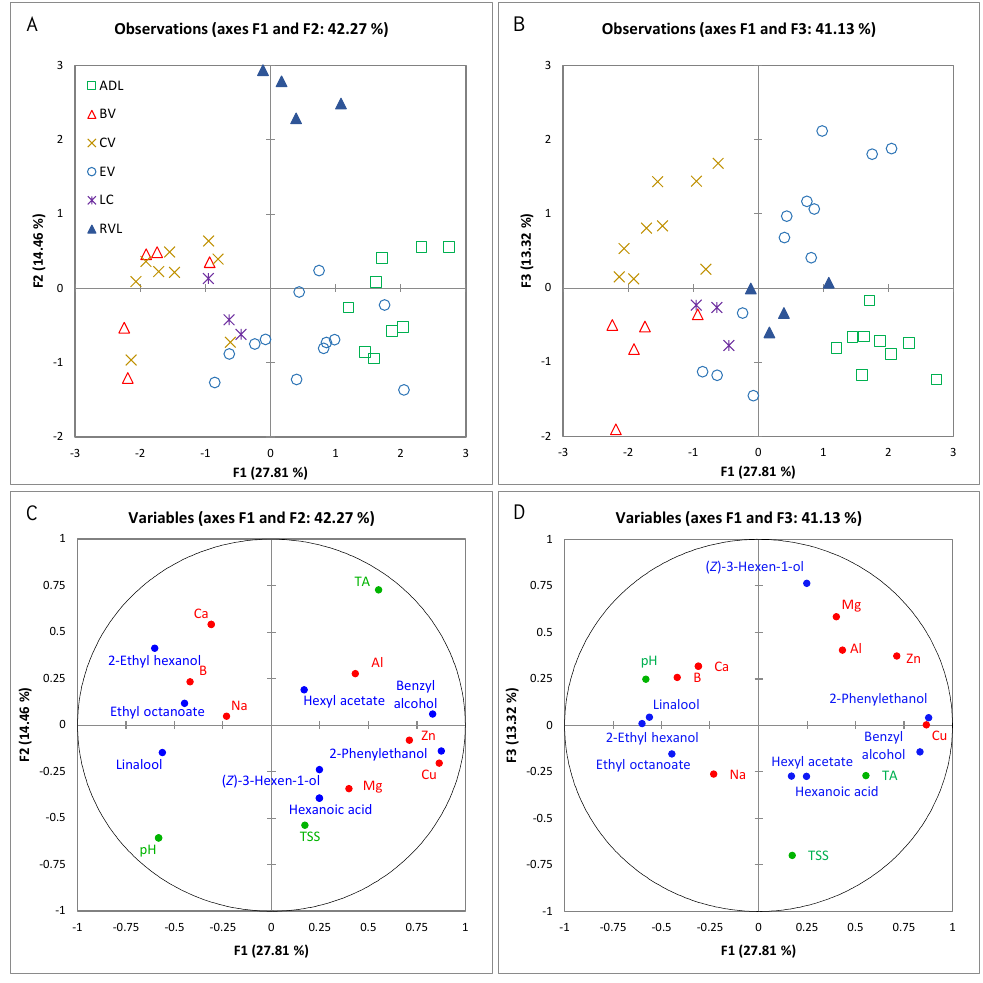
Figure 2 Figure 2. MFA of elements, free volatiles and basic chemistry data for all six GI in 2016, showing the scores projected on F1 and F2 ( A ) and F1 and F3 ( B ) for each GI, and loadings of variables used in the analysis on F1 and F2 ( C ) and F1 and F3 ( D ) (basic chemistry in green, elements in red and free volatiles in blue). ADL, Adelaide Hills; BV, Barossa Valley; CV, Clare Valley; EV, Eden Valley; LC, Langhorne Creek; RVL, Riverland. Abbreviations (e.g., TSS, TA) are the same as specified in the